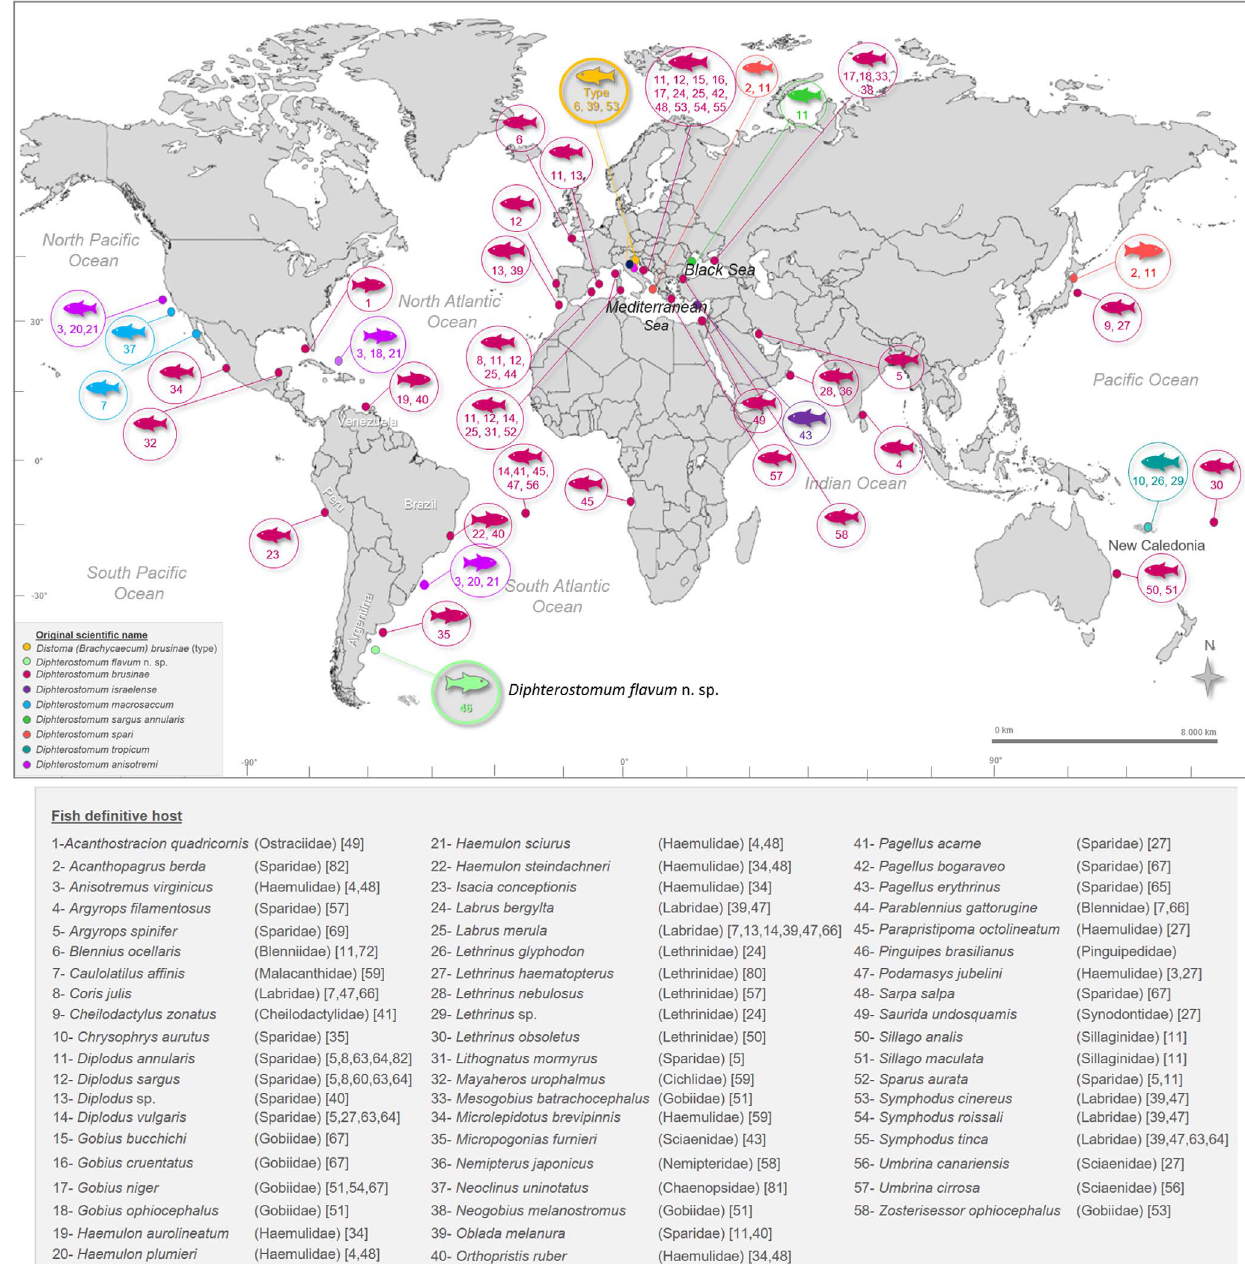
Figure 1. Geographical distribution of species described as Diphterostomum brusinae (Stossich, 1888) (Digenea, Zoogonidae) from fi sh around the world. References for each record are given between